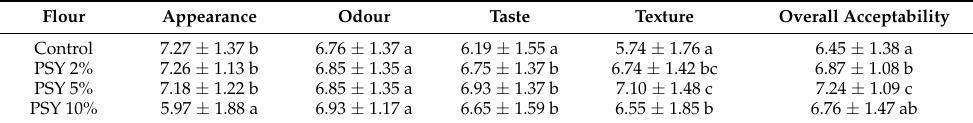
Table 4. Sensory acceptability of control and psyllium added breads. Flour